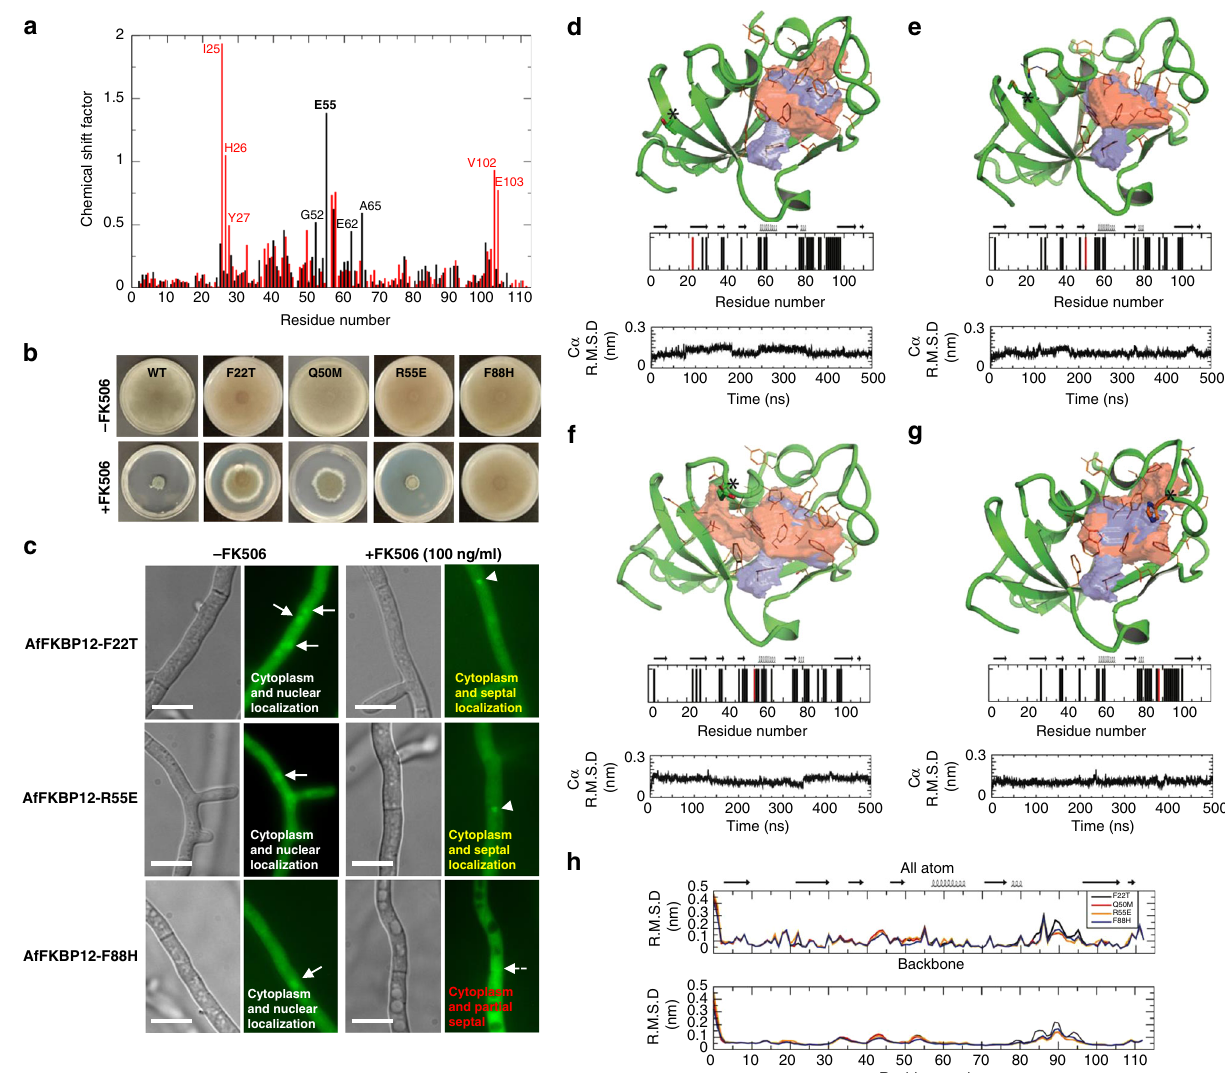
Fig. 2 Structural implication of AfFKBP12 mutations. a NMR analysis showing chemical shifts induced by FK506 binding to A. fumigatus (red) and human (black) FKBP12. b Growth of the Affkbp12 mutants in the absence and presence of FK506 for 5 days at 37°C. c Microscopic localization AfFKBP12 mutated proteins in vivo in the absence or presence of FK506. Arrows show nuclear localization of AfFKBP12. Arrowheads indicate binding of AfFKBP12 to CN at the hyphal septum ( d F22T, e Q50M, f R55E, g F88H). The FK506-binding pocket of WT (blue surface) and the pocket resulting from the mutation (red surface) are shown. Mutation site is denoted with an “ * ” and shown in stick format (red bar in bar graph), while residues comprising the binding pocket are shown in orange lines (black bars in bar graph). The stability and quality of the simulation is shown in the C α RMSD plot. h The all atom (top) and backbone (bottom) RMSD denoting the structural variation due to the mutation compared to the WT structure (5HWB). See also Supplementary Figs. 1 and